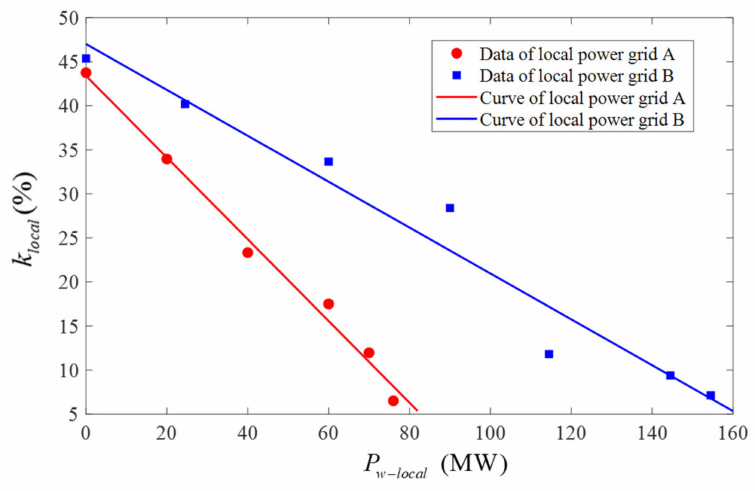
Figure 8. PV curves corresponding to different wind power integration capacity values in the local power grids A and B; ( a ) PV curves at the node KL in the local power grid A; ( b ) PV curves at the node LH in the local power grid B.